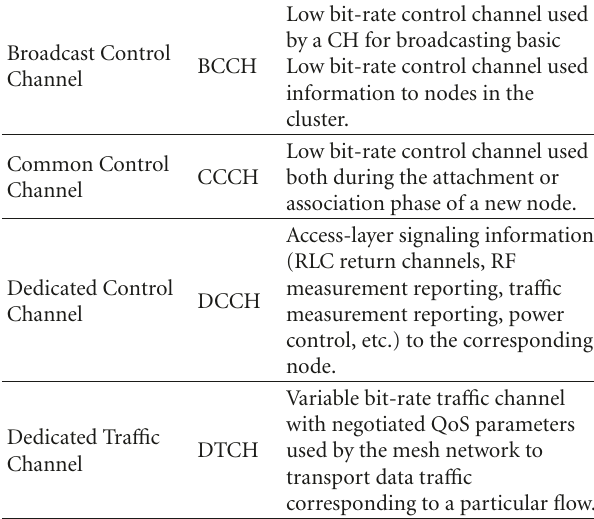
Table 3: Logical channels.